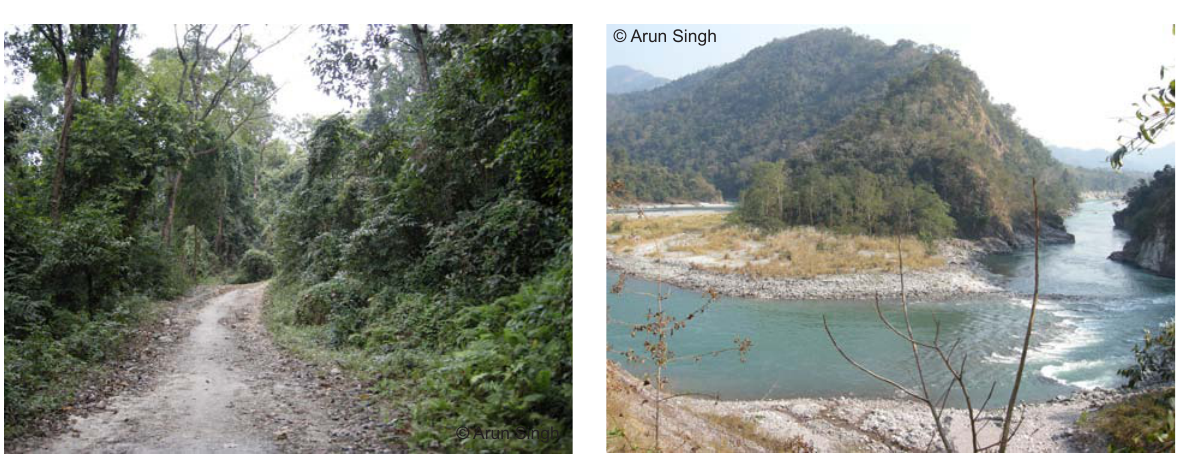
Image 3. Low forest habitat during the monsoon season (July) near Kalikhola